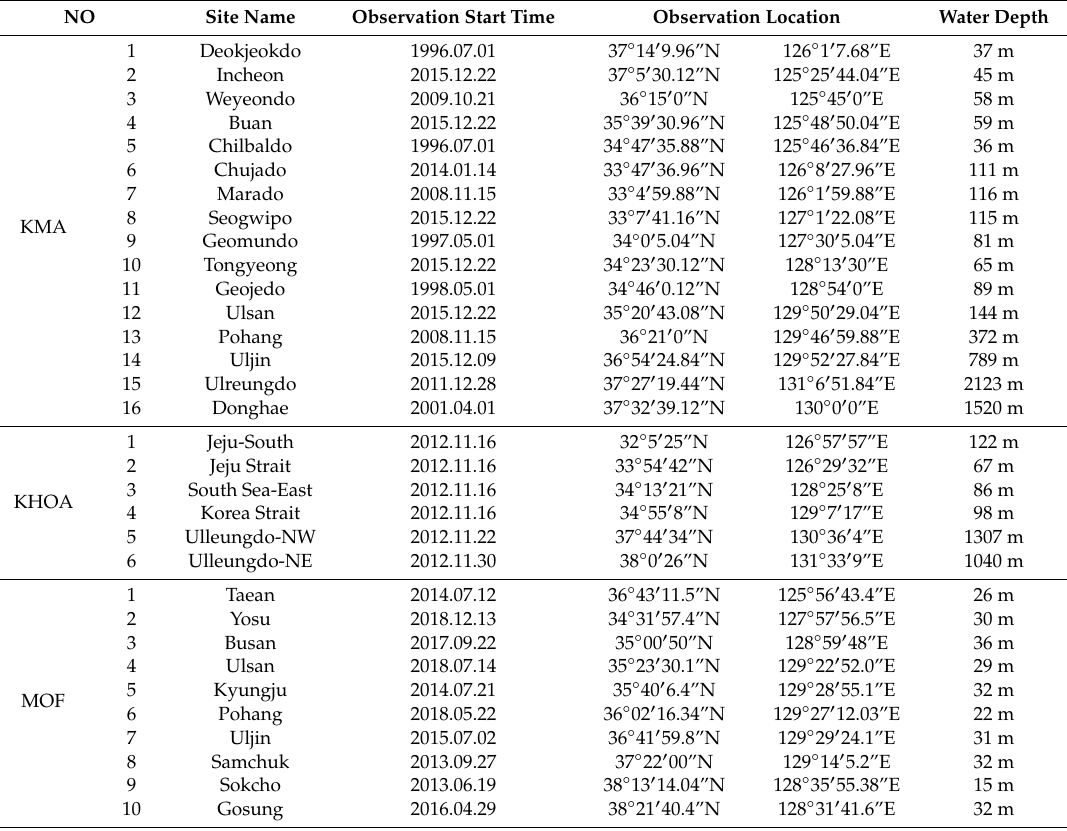
Table 2. Summary of wave observation data provided by the WINK